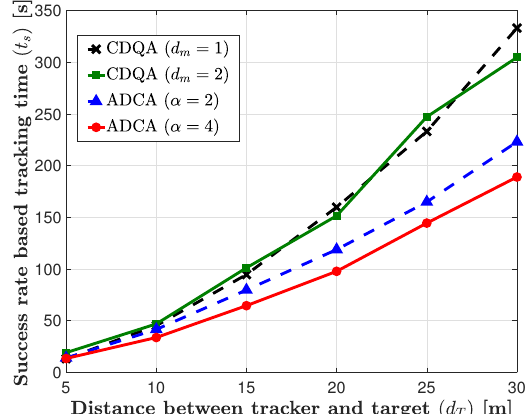
Figure 5. Performance Comparison of constant distance and quantized angle (CDQA) and adaptive distance and continues angle